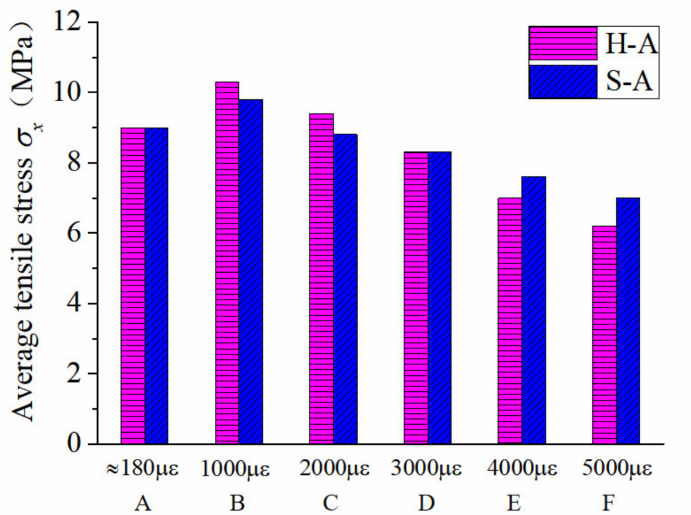
Figure 6. Comparison of the average tensile stress at each characteristic point for different